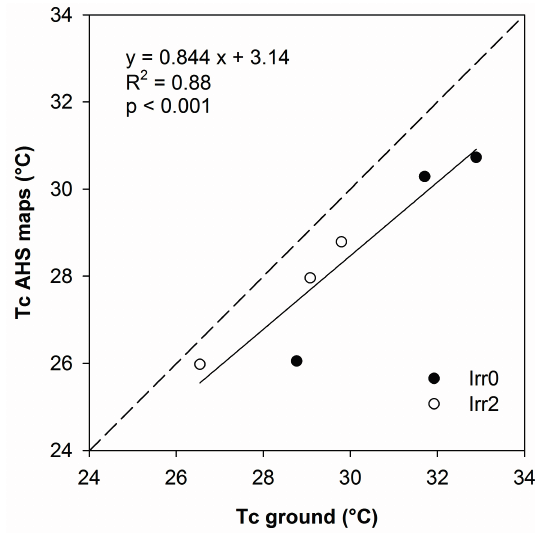
Figure 5. Relationship between the average Tc (°C) values measured on ground at the time of the three overpasses and the average value extracted from the airborne Tc maps for each of the two plots continuously